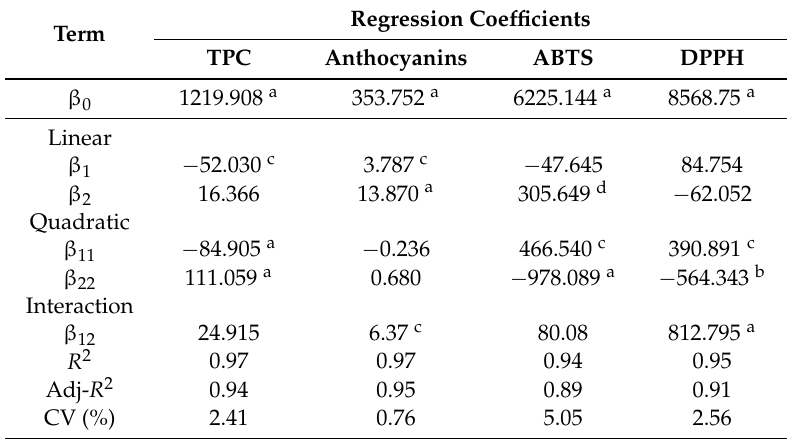
Table 2. Regression coefficients of the predicted models for TPC, anthocyanins and antioxidant activity.